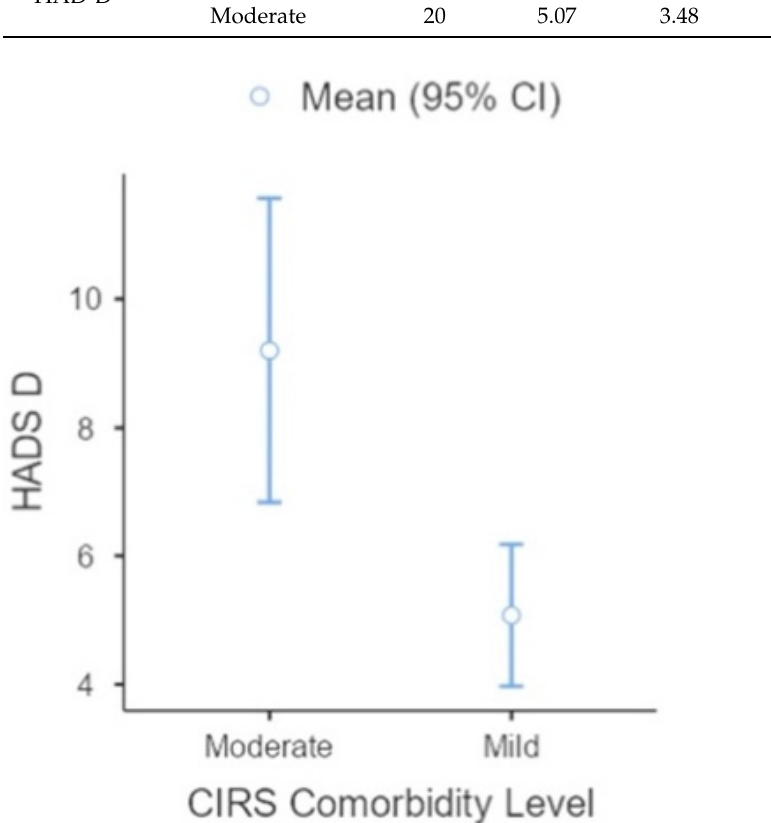
Figure 2. Representation of degree of depression distributed by moderate and mild CIRS indexes.